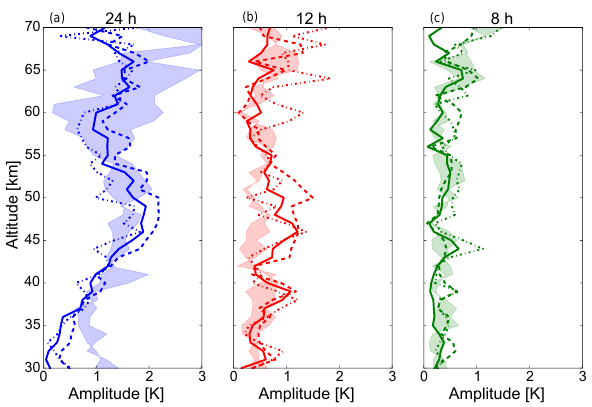
Figure 5. Amplitudes for the diurnal (a) , the semidiurnal (b) , and the terdiurnal (c) component derived from a composite analysis dur- ing 14 measurement days in May 2016 (solid line), the first days of May (dashed line), and the last days of May (dotted line). A defini- tion of the time intervals is given in Table 1. The shaded area shows the amplitudes derived from data in May 2012 and May